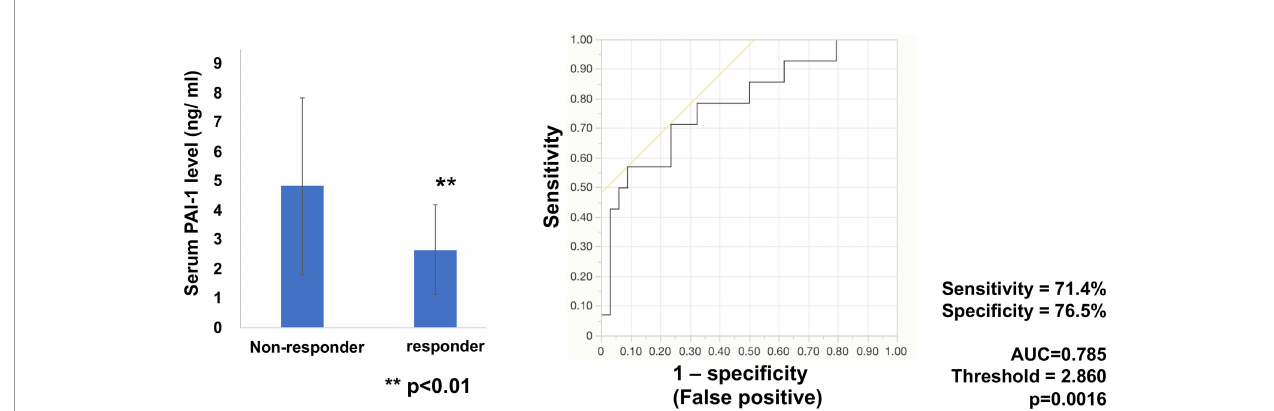
FIGURE 2 | Serum levels of PAI-1 and the ROC curve in melanoma. Mean serum levels of PAI-1 in non-responders (n=34) and responders (n=14) at day 0. The ROC curve was used to calculate cut-offs for PAI-1 serum levels and the AUC. Cut-offs were determined to distinguish responders from non-responders using Youden ’ s index.